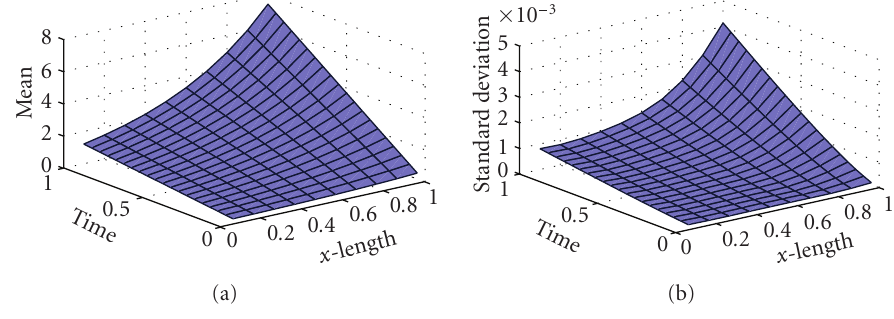
Figure 6.1. The solution moments at stochastic heat conductivity A .